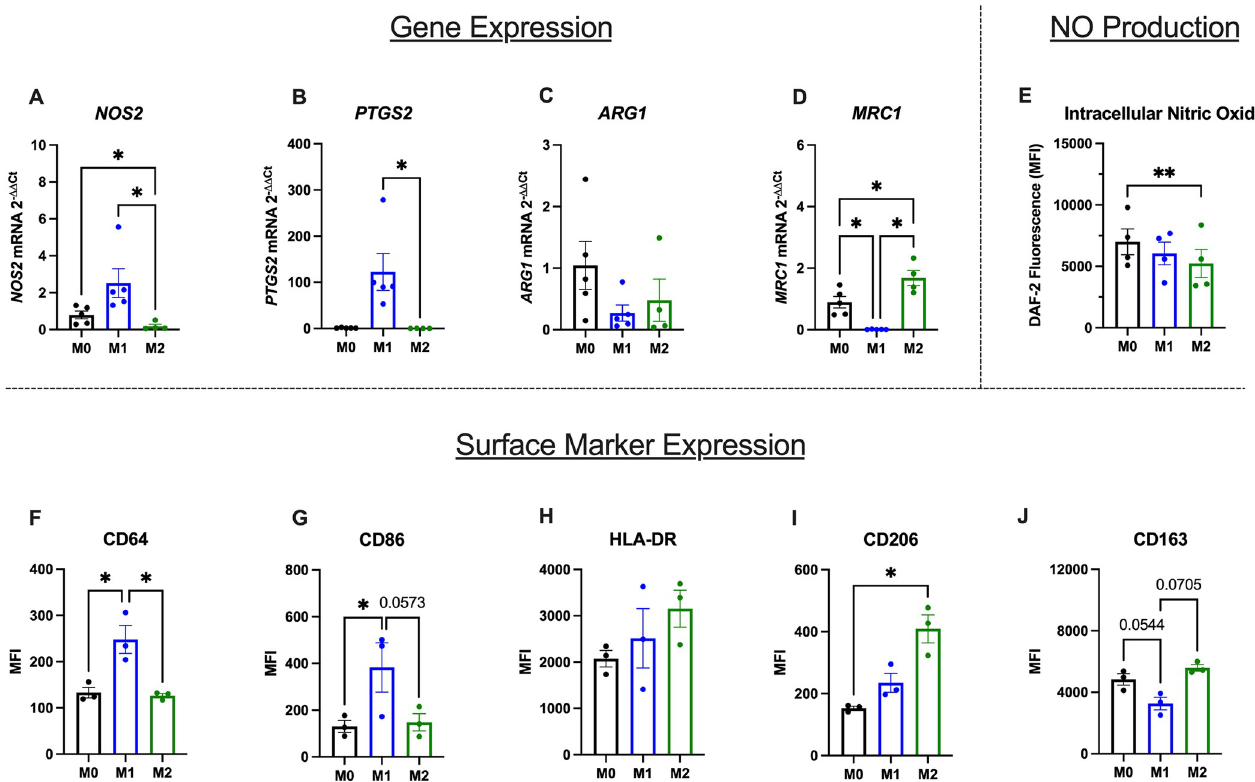
Fig 5. Polarization of hMDMs induces changes in gene expression and cell surface marker expression. hMDM polarization-induced changes in gene expression of (A) NOS2, (B) PTGS2, (C) ARG1, and (D) MRC1 are shown. M1 hMDMs express higher levels of CD64 (E) and CD86 (F) than M0 and M2 hMDMs. There were no significant differences in HLA-DR (G) across polarization states. CD206 expression (H) is significantly increased in M2 hMDMs, and CD163 expression (I) is decreased in M1 hMDMs in comparison to M0- and M2 hMDMs. N = 5 biological replicates (3 males, 2 females for M0 and M1; RNA extraction failed on one M2 sample, resulting in 3 males and 1 female for the M2 group) for gene expression data and n = 3 biological replicates (all males) for cell surface marker data. For both gene and cell surface maker data, samples were pooled from two technical replicates per biological replicate and polarization state. All data are presented as mean ± SEM. For gene expression data, � p < 0.05 by Friedman test with Holm-Sidak multiple comparisons test (which allows for missing values). For cell surface marker data, � p < 0.05 by repeated measures one-way ANOVA with Tukey’s test for multiple